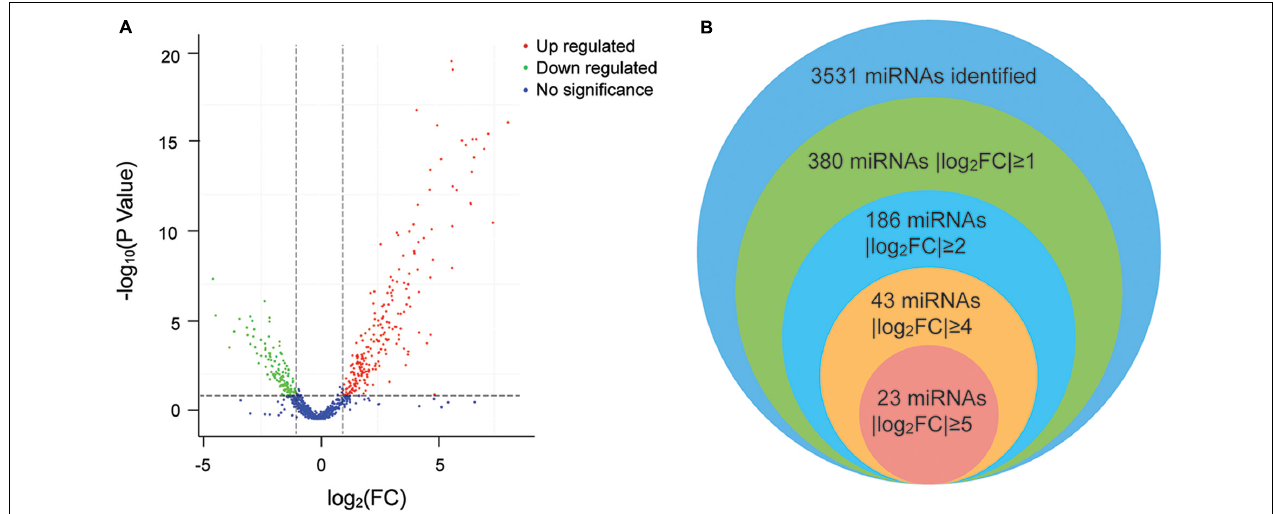
FIGURE 2 | (A) Volcano plot of the differentially expressed miRNAs. The plot shows the log 2 fold change on the X -axis vs. the adjusted P values (on the log10 scale) on the Y -axis. Red dots indicate upregulated miRNAs, green dots are downregulated miRNAs, and blue dots are miRNAs with no significant difference. (B) Venn diagram of the differentially expressed miRNAs. Each circle represents a comparison group. The overlapping part is the common miRNAs among the comparison groups.